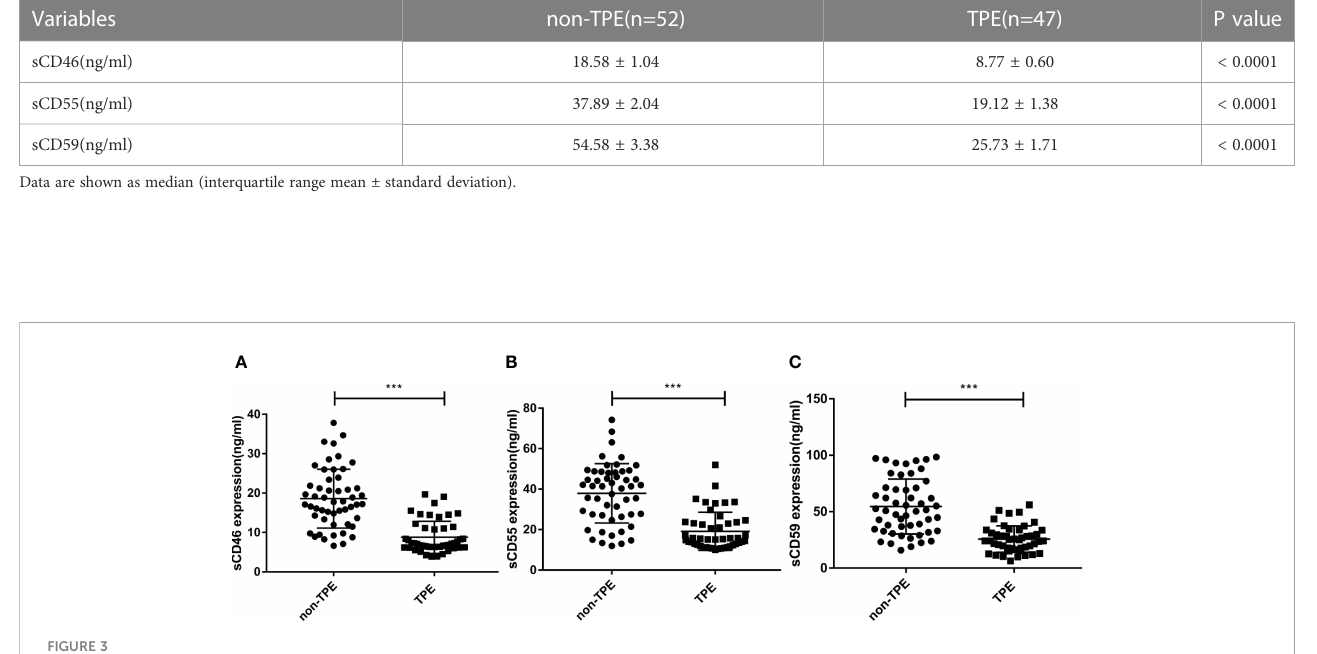
TABLE 2 The concentration of sCD46, sCD55, and sCD59 in pleural effusion. Variables